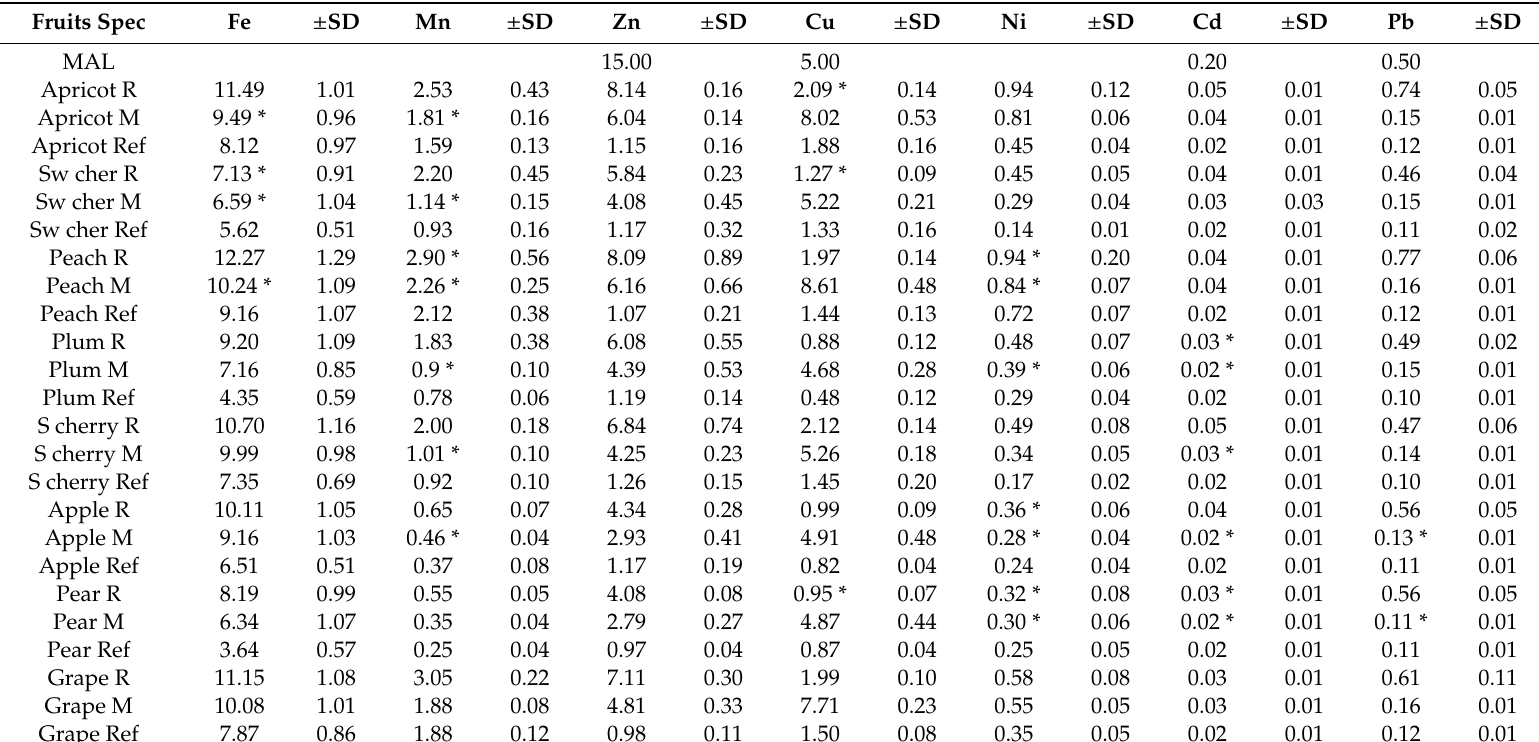
Table 5. Mean (and SD) for metal concentrations in analyzed fruits (mg / kg